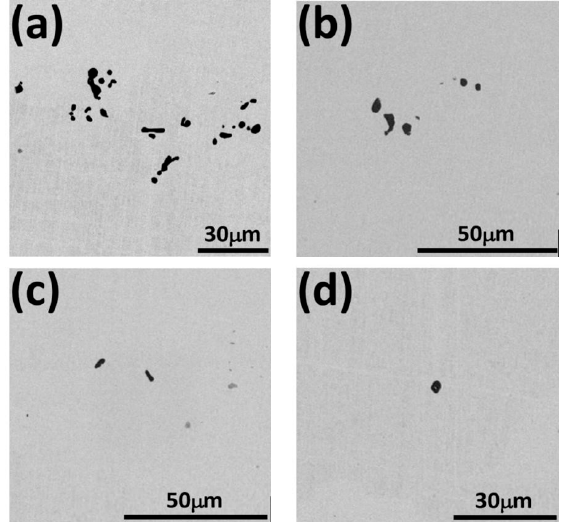
Figure 1. SEM (Scanning Electron Microscope) images of Al 2 O 3 inclusions from sample: ( a ) a large number of Al 2 O 3 inclusions gathered together to form a cluster distribution; ( b ) a small amount of Al 2 O 3 gathered together; ( c ) Al 2 O 3 inclusions were long strip-shaped and with a lone distribution; ( d ) Al 2 O 3 inclusions were mainly irregular in shape.